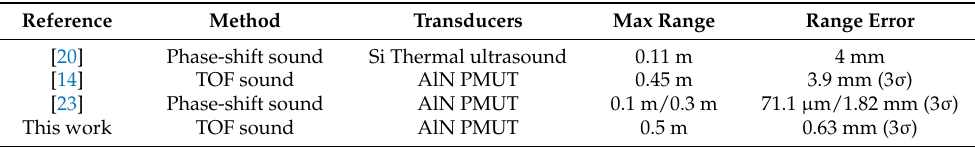
Table 2. Performance comparison with previous